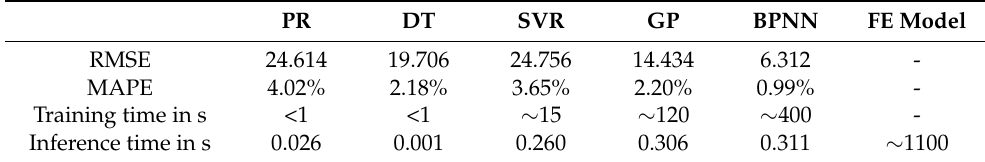
Table 6. Results of the models on the test set for Use Case 2. PR DT SVR GP